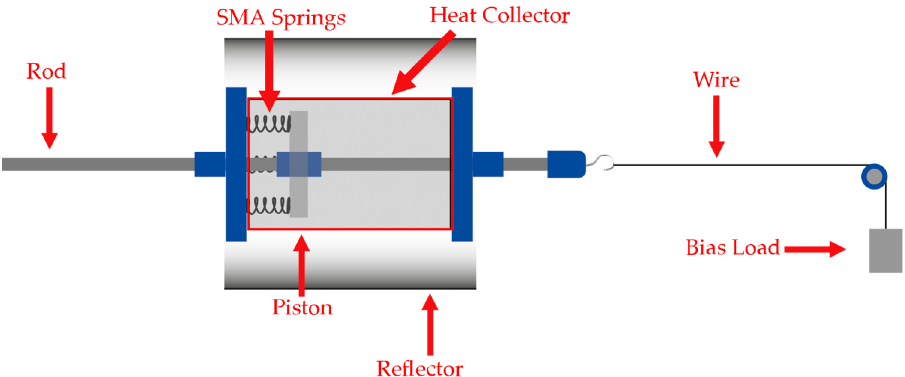
Figure 1. Conceptual design of the solar-driven SMA thermomechanical actuator.